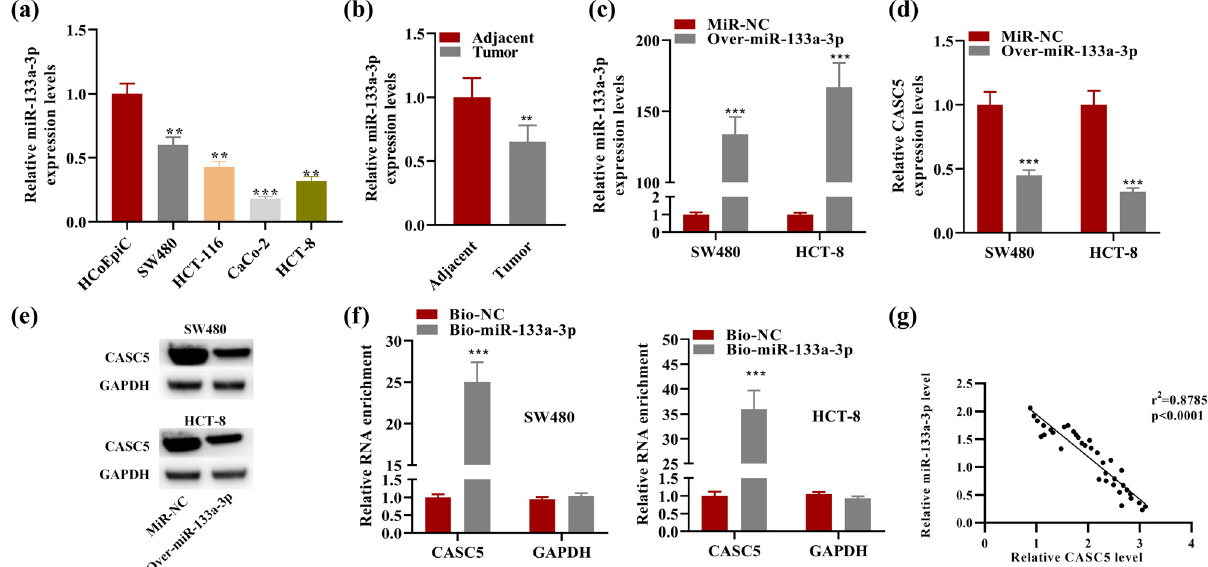
Figure 2: ( a ) Relative miR - 133a - 3p expression in HCoEpiC and four other CRC cell lines. ( b ) Relative expression of miR - 133a - 3p in adjacent and tumor. ( c ) Relative miR - 133a - 3p expression in SW480 and HCT - 8 cell lines transfected with over - miR - 133a - 3p/miR - NC. ( d ) Relative CASC5 expression in SW480 and HCT - 8 cell lines transfected with over - miR - 133a - 3p/miR - NC. ( e ) Western blot results of CASC5 in SW480 and HCT - 8 cell lines transfected with over - miR - 133a - 3p/miR - NC. ( f ) RNA pull - down results were used to detect the enrichment of CASC5 and GAPDH ( negative control ) in the complex pulled down by bio - miR - 133a - 3p or bio - NC. ( g ) The expression correlation between miR - 133a - 3p and CASC5 in CRC patient tissues was explored using Pearson correlation analysis. ** P < 0.01, *** P <